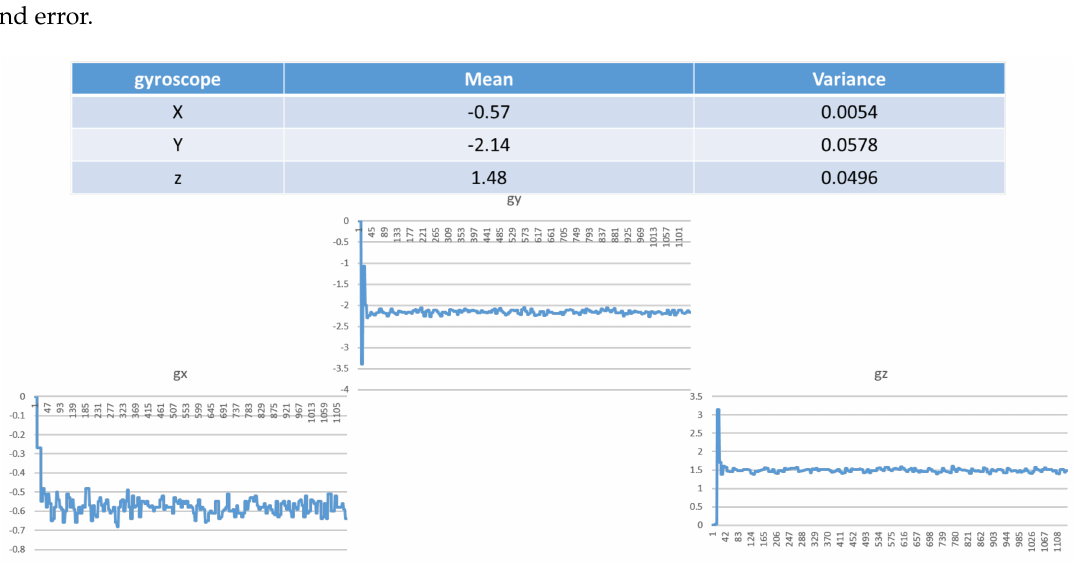
Figure 5. Mean and variance of the gyroscope in the x, y and z directions.